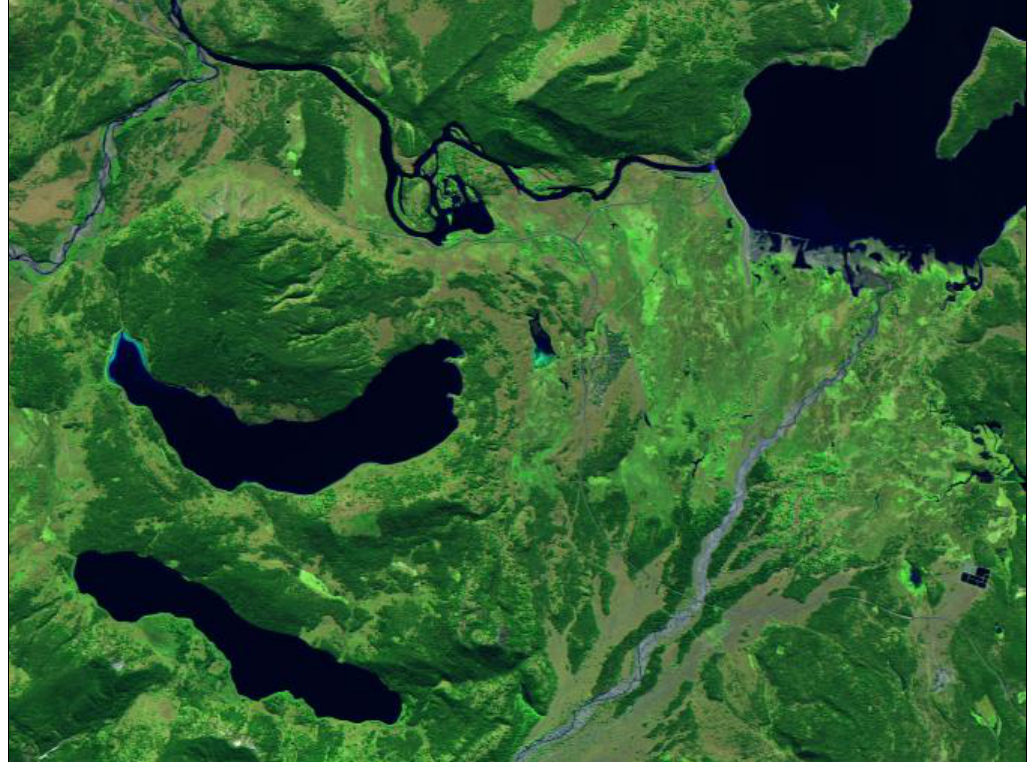
Figure 4. Yellowstone Scene 11, with band 125 assigned to red component, band 70 to green and band 30 to